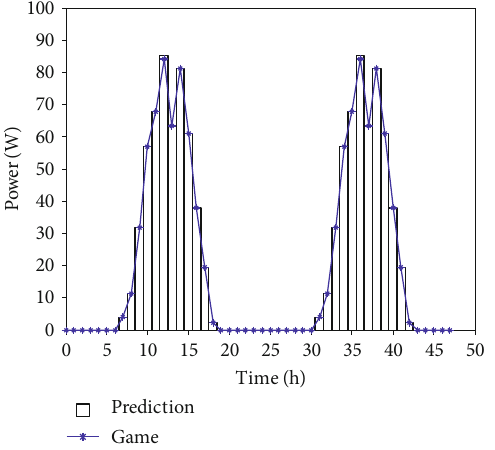
Figure 6: Comparison of optimal power generation and maximal output power of PV.